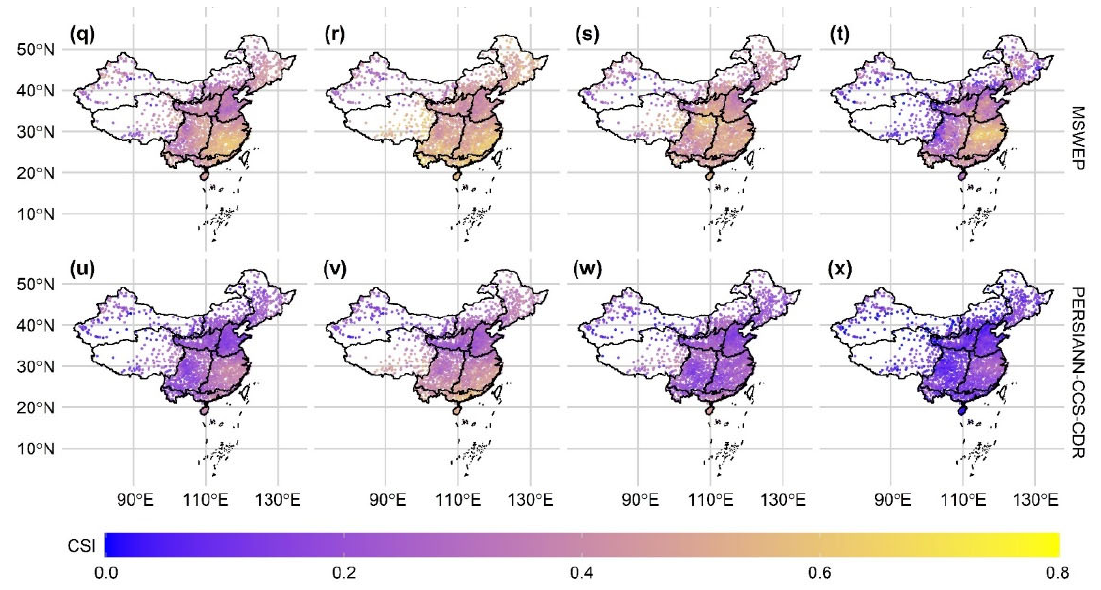
Figure 12. Distribution of the CSI values of six products for different seasons between 2015 and 2019. From top to bottom: (a–d) CHIRPS, (e–h) ERA5 ‐ Land, (i–l) GSMaP, (m–p) IMERG, (q–t) MSWEP and (u–x) PERSIANN ‐ CCS ‐ CDR.